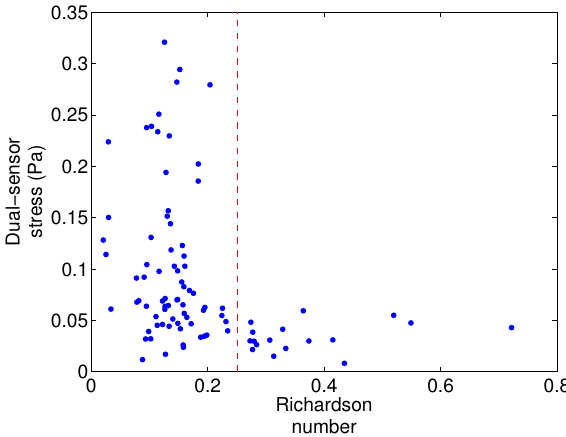
Figure 8. Variation of the direct estimates of near-bed stress with Ri . Red dashed line indicates Ri = 0.25. Using these direct estimates of near-bed stress (the most fundamental method of the three methods used), the bed drag coefficient is estimated as C d = ( u ∗ / U cur ) 2 through quadratic drag relation. Applying a linear least-square regression between the direct estimates and quadratic estimates (Figure 9) results in average bed drag coefficients of C d = 0.0029 for the East–West component ( r 2 = 0.74) and C d = 0.0023 for the North–South component ( r 2 = 0.66). To get more insight into the